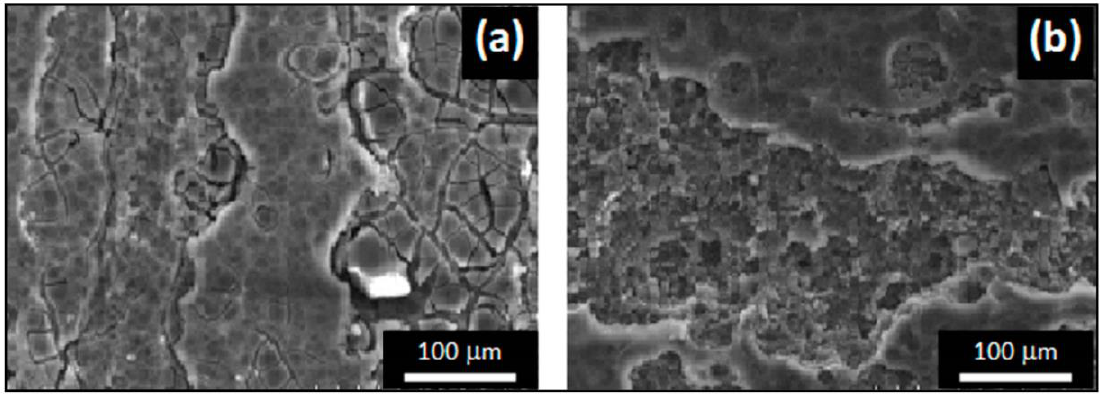
Figure 5. Surface morphology of ( a ) conventional rebar and ( b ) DP rebar.